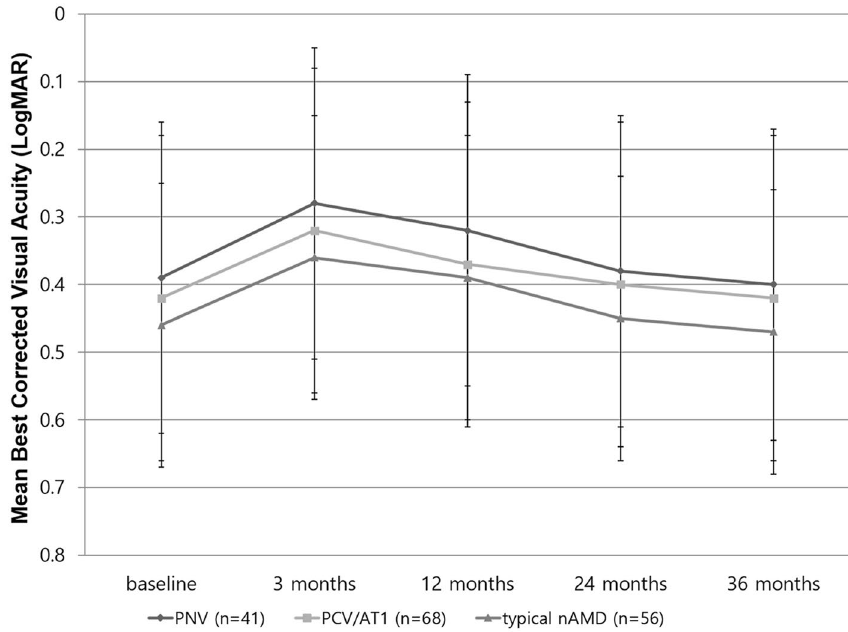
Figure 2. Changes in mean best-corrected visual acuity (BCVA), expressed as logarithm of the minimal angle of resolution, during the 36-month anti-vascular endothelial growth factor treatment for macular neovascularization. The BCVA at 3 months was significantly different between the pachychoroid neovasculopathy (PNV), polypoidal choroidal vasculopathy/aneurysmal type 1 neovascularization (PCV/AT1), and typical neovascular age-related macular degeneration (nAMD) (ANOVA, P = 0.031). However, there was no significant difference between the groups at 12, 24, and 36 months.